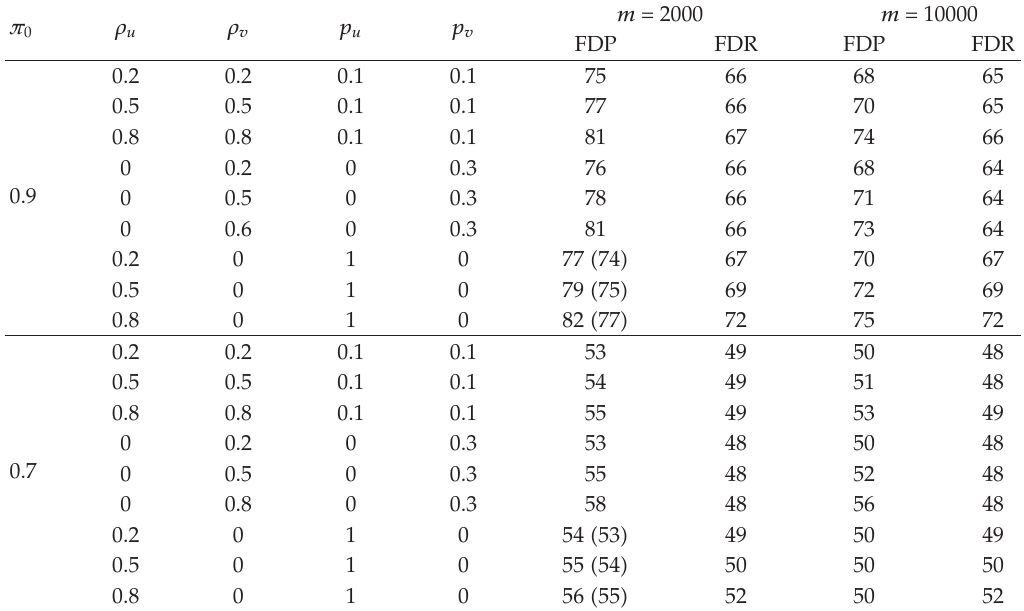
Table 2: Sample size calculation for controlling FDP and FDR to achieve overall power, blockwise correlation